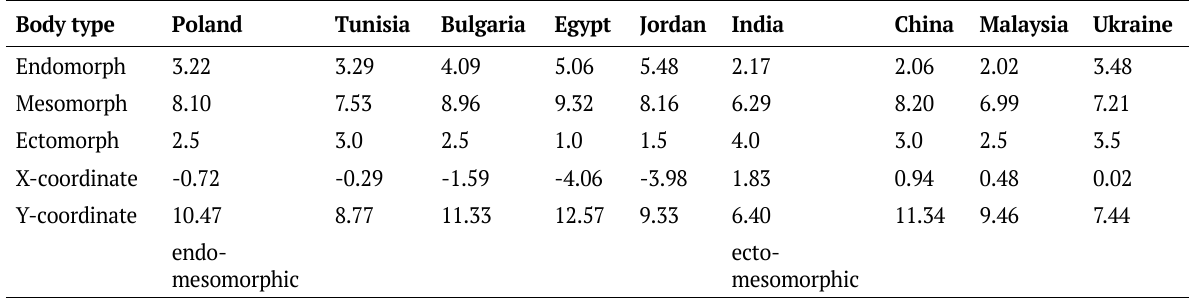
Table 6. Components of the constitution of the body of students Body